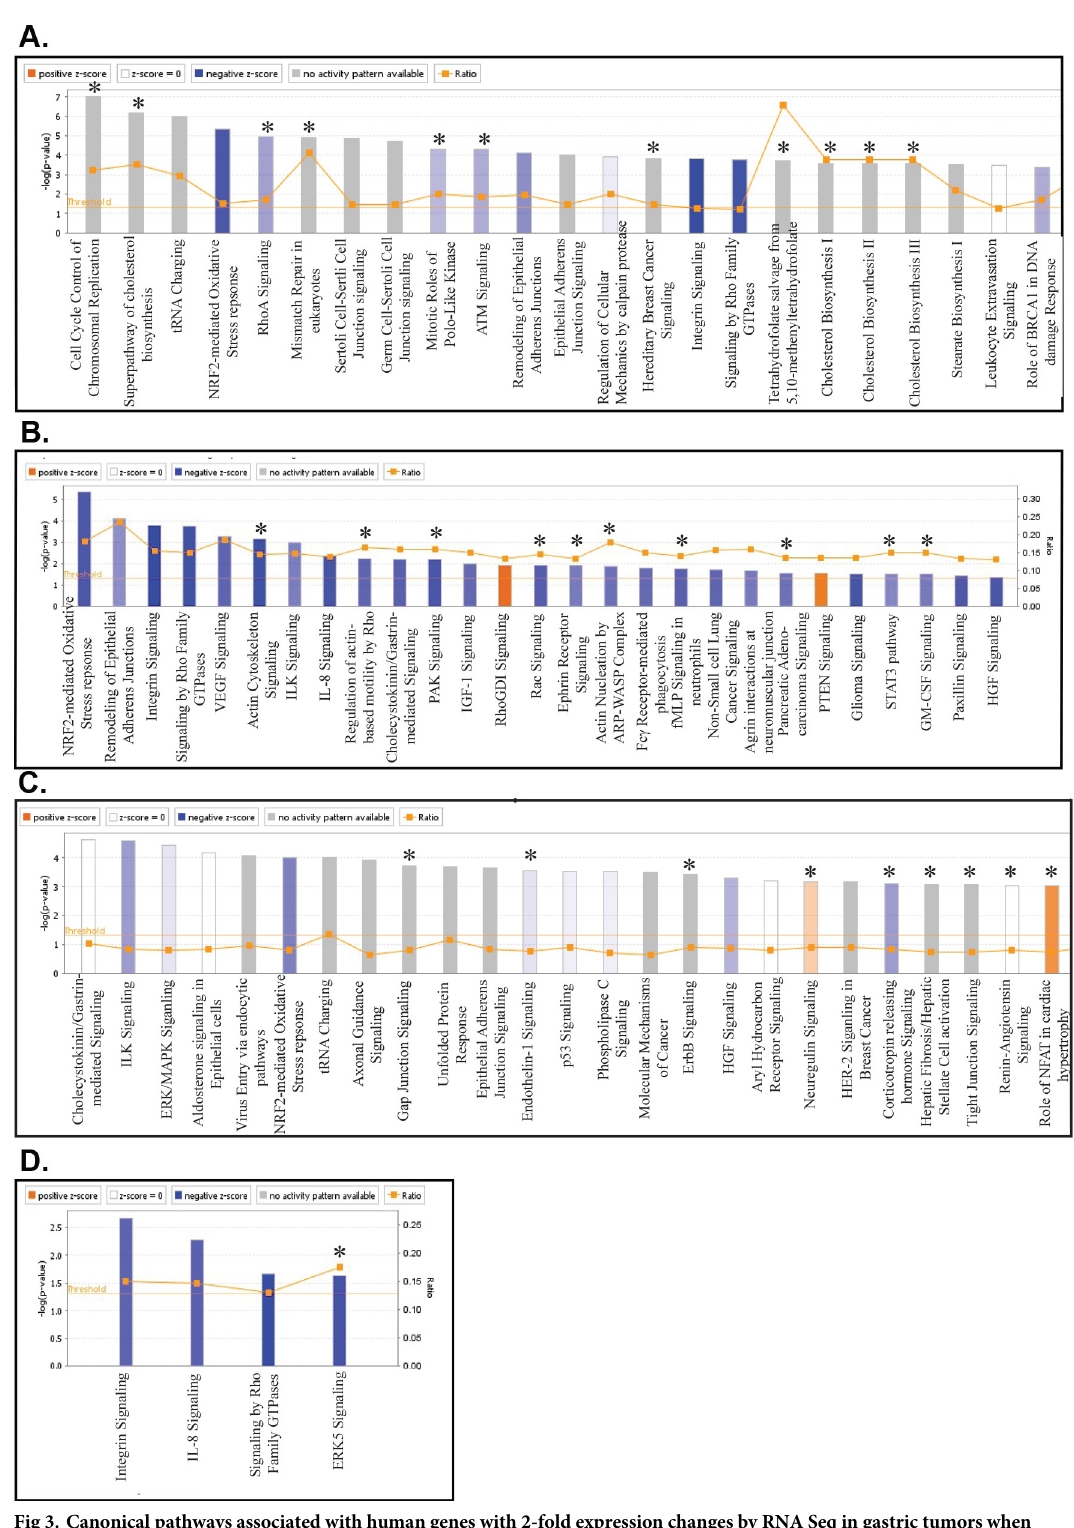
Fig 3. Canonical pathways associated with human genes with 2-fold expression changes by RNA Seq in gastric tumors when compared to the gastric cell lines. (A) Top canonical pathways associated with human genes with 2 fold expression change by RNA seq in the AGS tumors compared to AGS cell line. Astericks ( � ) denote pathways unique to the comparison of AGS tumor to their cell line. (B) Significant canonical pathways (absolute z-score � 2) associated with AGS tumors compared to AGS cell line. The height of